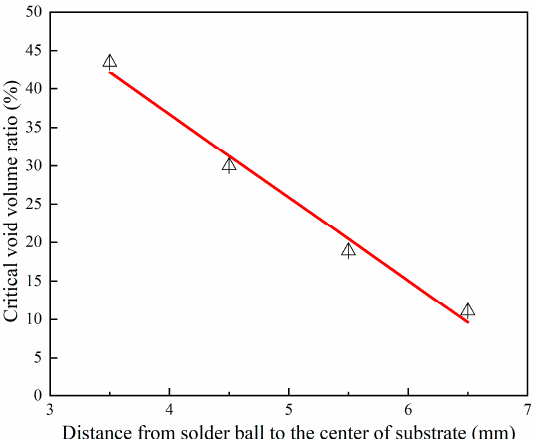
Figure 11. The relationship between critical void volume ratio and location of solder ball.